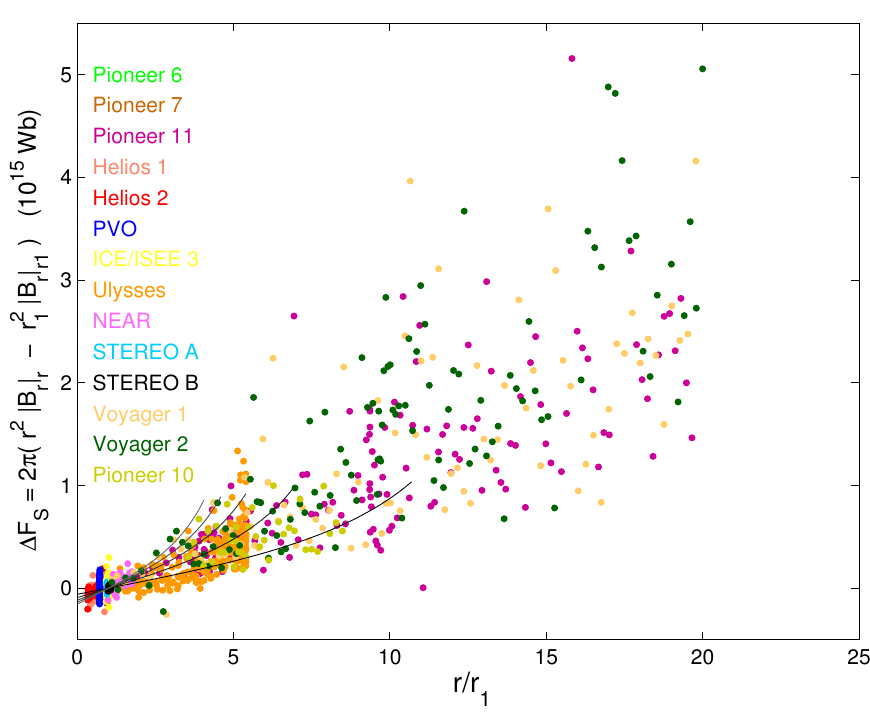
Figure 18: A comparison of Δ 𝐹 values, as a function of 𝑟/𝑟 1 (where 𝑟 1 = 1 AU), computed using Equation (7) for T = 1 h and averages over Carrington rotations (i.e., ⟨| 𝐵 𝑟 ( 𝑟 ) | 1h ⟩ 27d is used for both the heliospheric and simultaneous near-Earth data) from 14 heliospheric spacecraft: Pioneer 6, Pioneer 7, Pioneer 10, Pioneer 11, Helios 1, Helios 2, Pioneer Venus Orbiter (PVO), International Sun-Earth Explorer ISEE3 (later renamed International Cometary Explorer, ICE), Ulysses, Near-Earth Asteroid Rendezvous (NEAR), Solar Terrestrial Relations Observatory (STEREO) A, STEREO B, Voyager 1, and Voyager 2. The lines show the distribution of predicted Δ 𝐹 from the “kinematic correction” calculated for each sample (Lockwood et al. , 2009c), which are exceeded a fraction 𝑝 of the time, where 𝑝 is 0.1 (for black line), 0.25, 0.5, 0.75, and 0.9 (light gray line). Image reproduced by permission from Lockwood et al. (2009c), copyright by